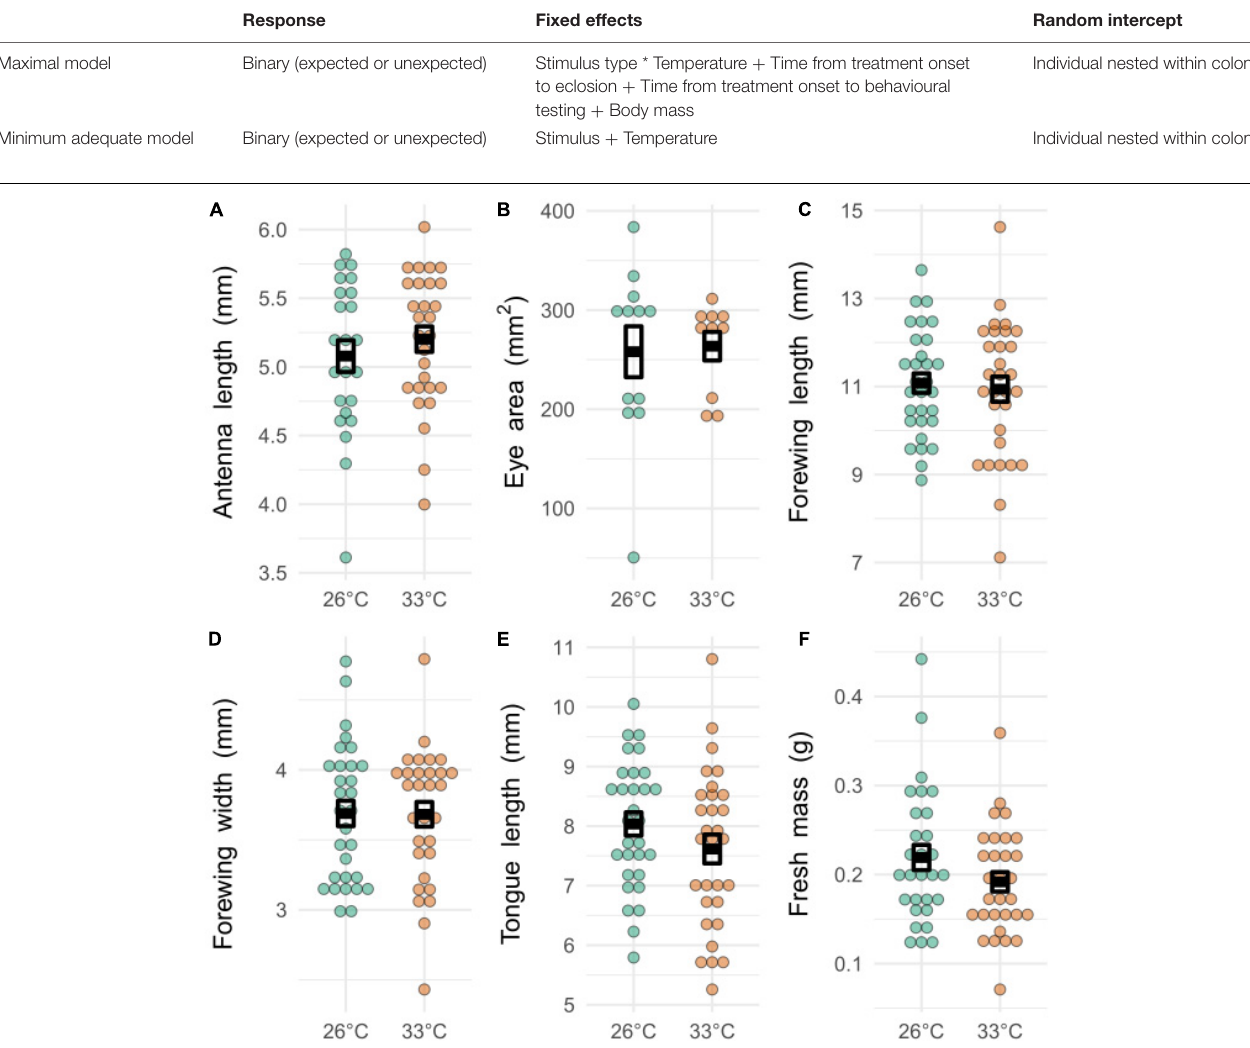
FIGURE 3 | Morphological measurements from bees exposed to developmental heatwaves of different temperatures. Each dot represents a single measurement from an individual bee. Dark boxes represent means ± S.E. There was no significant difference between the mean values of any of the morphological measurements. (A) Antenna length: t 51 , 44 . 4 = 0.83, p = 0.41, size range = 3.61–6.02 mm. (B) Eye area: t 22 , 16 . 96 = 0.19, p = 0.85, size range = 0.005–0.0384 mm 2 . (C) Forewing length: t 60 , 54 . 64 = 0.38, p = 0.70, size range = 7.12–14.6 mm. (D) Forewing width: t 60 , 57 . 96 = 0.04, p = 0.96, size range = 2.43–4.79 mm. (E) Tongue length: